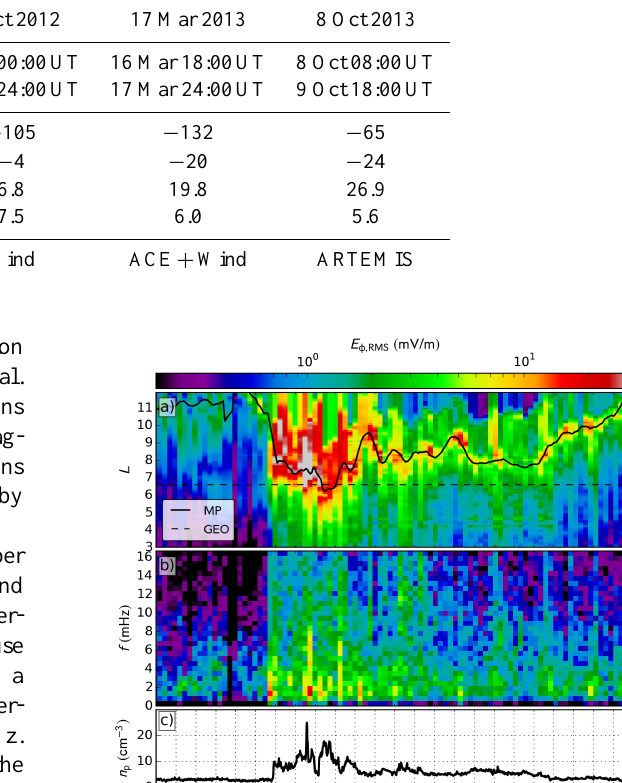
Table 1. Event summary: peak E φ in westward direction measured at GEO.